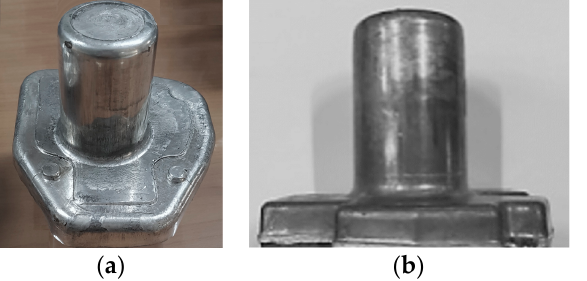
Figure 7. Appearance of final samples by forming process using semi-solid billets: ( a ) A356; ( b ) A6061.